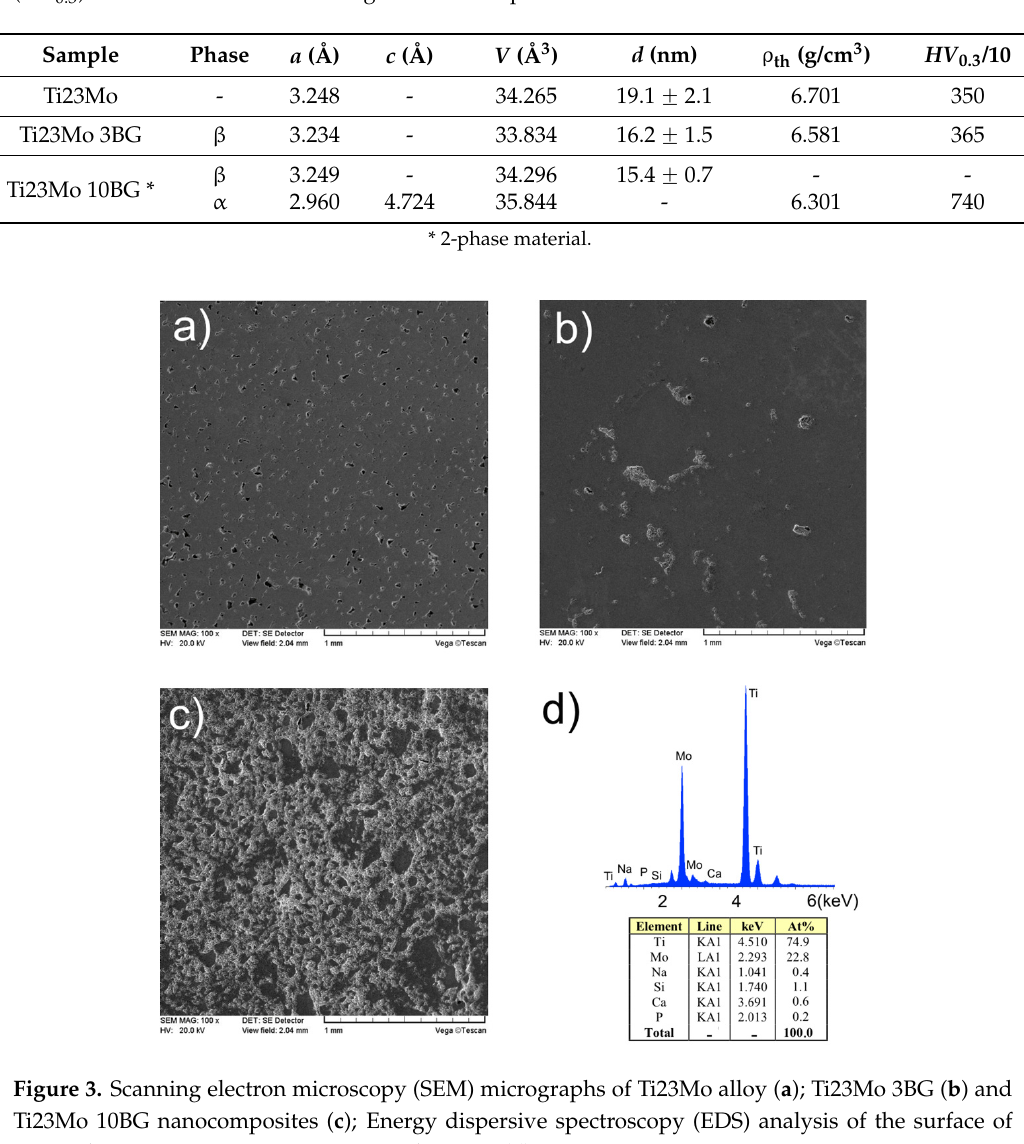
Table 1. Structural parameters ( a , c , V ), crystallite size ( d ), theoretical density ( ρ th ) and microhardness